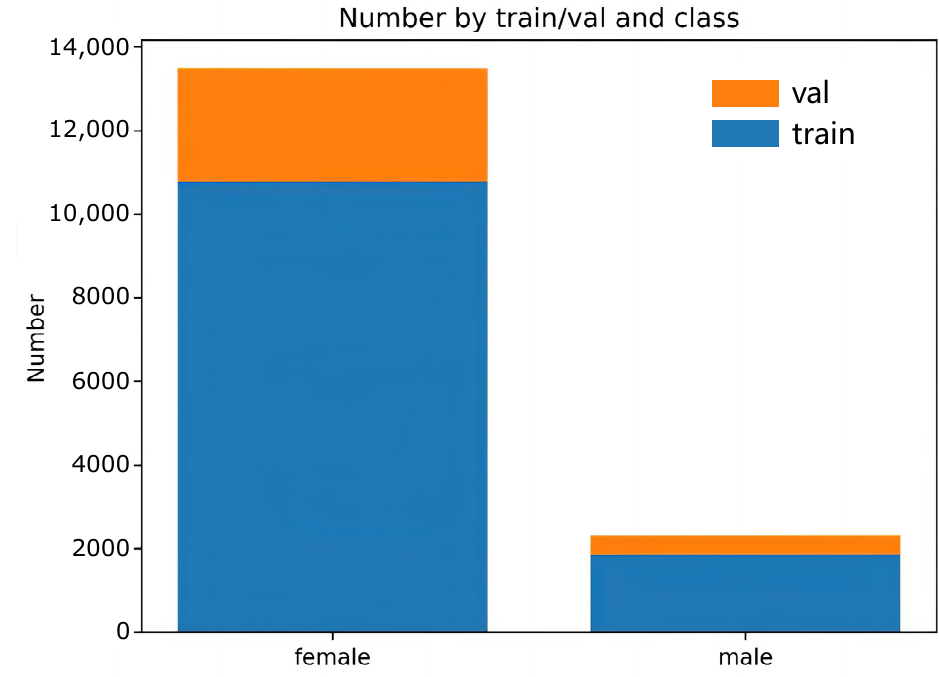
Figure 6. The average sex ratio of ducks in the population images.